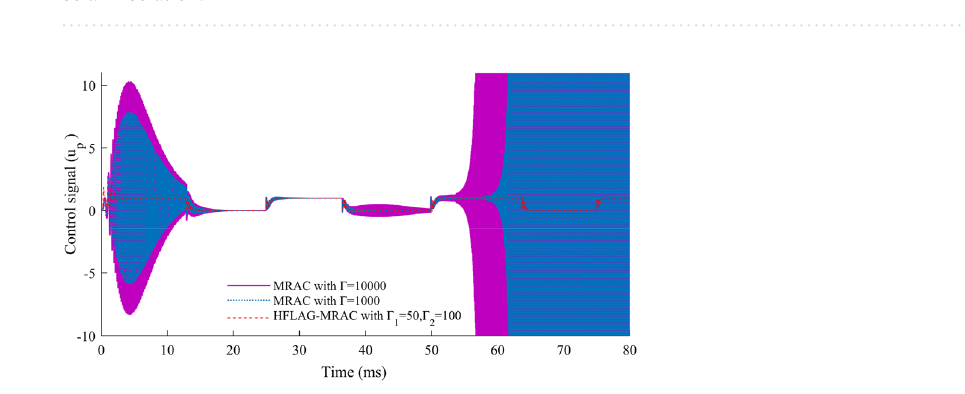
Figure 19. Output comparison of the proposed HFLAG-MRAC with other control schemes under varying solar insolation.